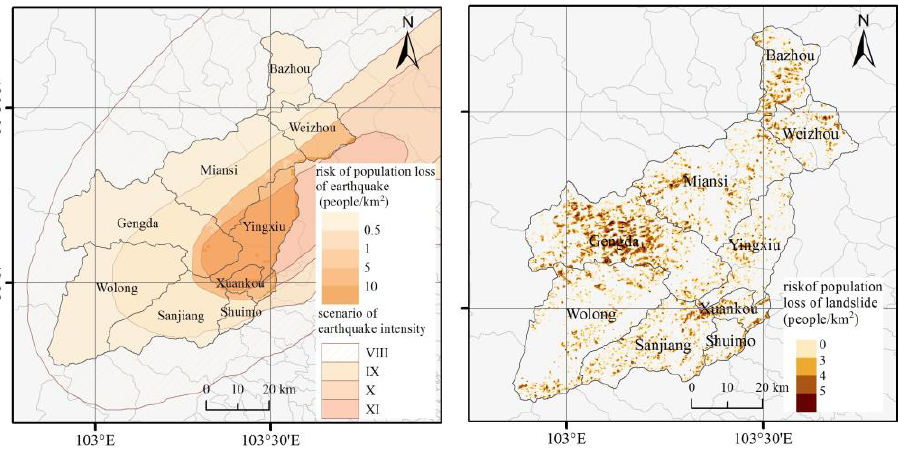
Figure 9. Spatial analysis of the population loss risks posed by the earthquake and landslides under the Ms8.0 earthquake scenario. the Ms8.0 earthquake